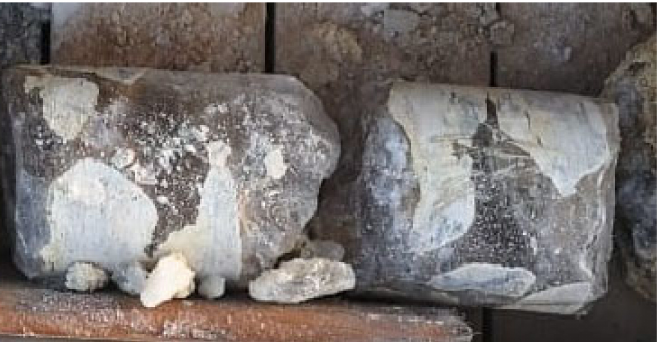
Figure 3. Ice-cemented carbonate breccia (core sample from the right abutment of the tailing dump). The high ice content is because before undergoing significant changes associated with the cryolithogenesis of this area in the Quaternary period, the studied interval belonged to the zone of intensive water exchange of the first fresh aquifer from the surface [16]. Three genetic types of cracks were identified in the rock mass: lithogenetic, exogenous, and tectonic (Figure 4).